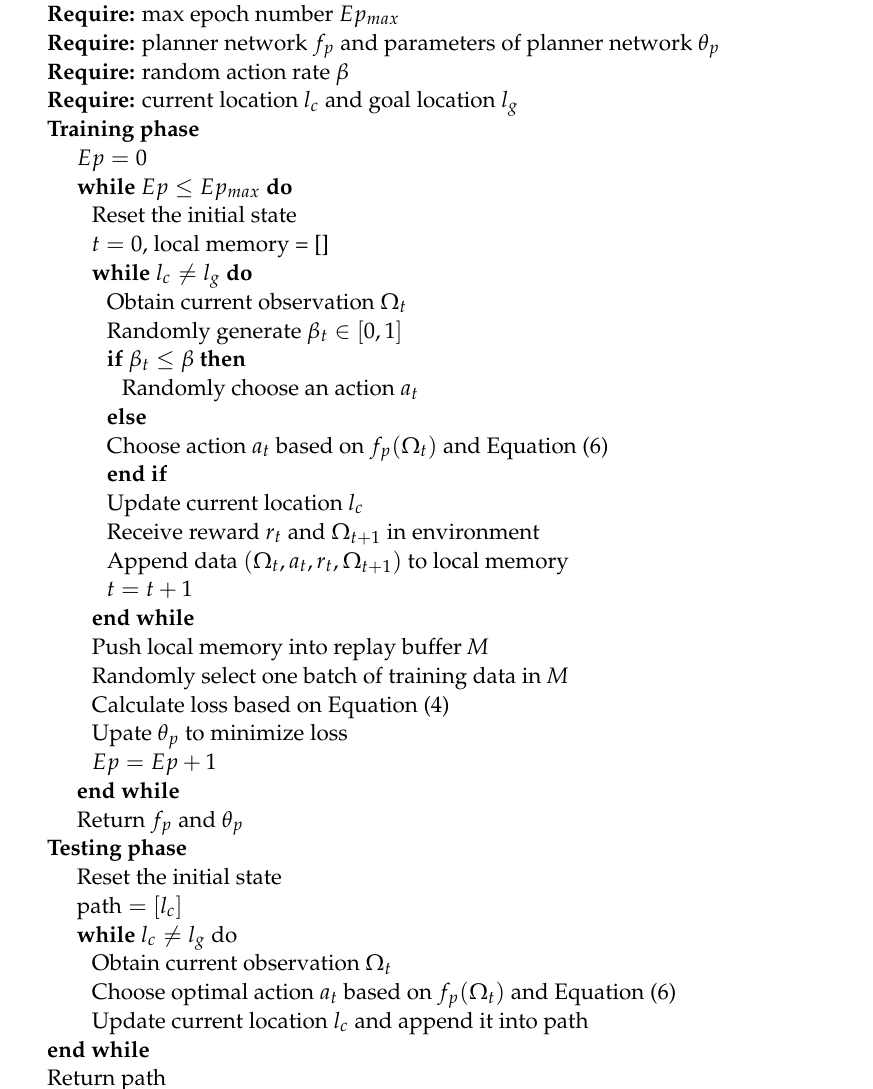
Algorithm 1. Algorithm for global path